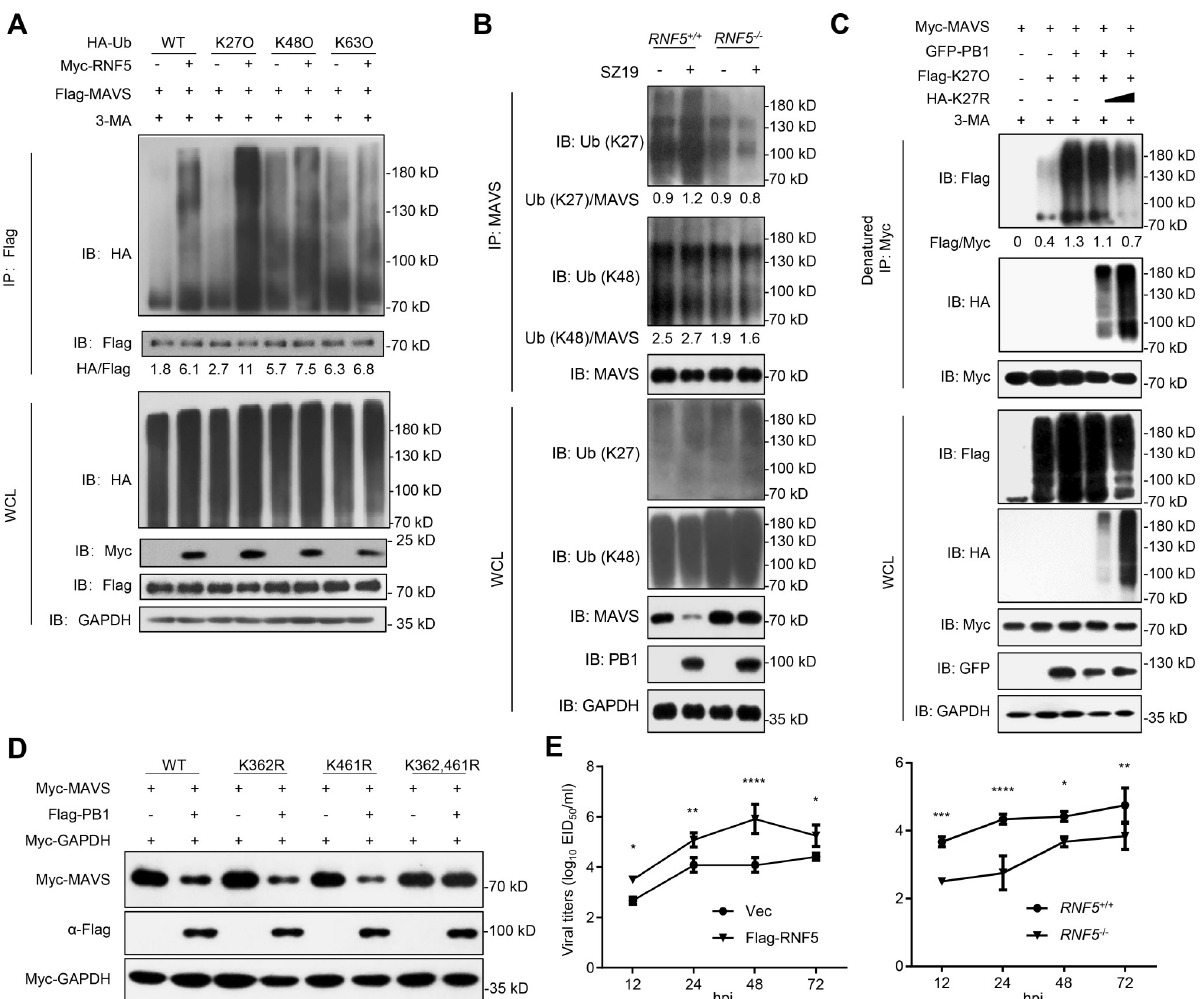
Fig 7. H7N9 PB1 facilitates RNF5 to ubiquitinate MAVS. (A) RNF5 catalyzes K27-linked ubiquitination of MAVS. HEK293 cells were transfected with Flag-MAVS, HA-ubiquitin, or its mutants (KO, K-only) together with a control and Myc-RNF5 plasmids for 20 h. The cells were then treated with 3-MA for 6 h before use in ubiquitination assays with the indicated antibodies. The intensities of the indicated protein bands were determined by using image J, were normalized to Flag-MAVS, and are shown as the fold-change of HA/Flag. (B) RNF5 deficiency inhibits SZ19-triggered K27-linked ubiquitination of MAVS. RNF5 -/- and control cells were infected with SZ19 virus (MOI = 0.1) for 24 h. The cells were then treated with 3-MA for 6 h before use in ubiquitination assays with the indicated antibodies. The intensities of the indicated protein bands were determined by using image J, were normalized to MAVS, and are shown as the fold-change of the indicated Ub/MAVS. (C) K27R ubiquitin inhibits PB1-mediated K27-linked ubiquitination of MAVS. HEK293 cells were transfected with Myc-MAVS, Flag-K27O, and HA-K27R (which K27 lysine residues was mutated to arginine) together with a control and GFP-PB1 plasmids for 20 h. The cells were then treated with 3-MA for 6 h before use in ubiquitination assays with the indicated antibodies. The intensities of the indicated protein bands were determined by using image J, were normalized to Myc-MAVS, and are shown as the fold-change of Flag/Myc. (D) MAVS bearing the K362 and 461R mutations is resistant to PB1-mediated degradation. HEK293 cells were transfected with Myc-MAVS and the indicated mutants in the presence or absence of Flag-PB1 for 24 h before immunoblot analysis. (E) The effects of overexpression or knockout of RNF5 on SZ19- Δ F2 virus replication. HEK293 cells were transfected with control vector or RNF5 plasmid for 24 h. The cells were then infected with SZ19- Δ F2 virus (MOI = 0.01) for the indicated times. The supernatants were harvested for virus titration (EID 50 /ml) (left). RNF5 -/- or control cells were infected with SZ19- Δ F2 virus (MOI = 0.01) for the indicated times. The supernatants were harvested for virus titration (EID 50 /ml) (right). The data shown represent three independent experiments; bars represent the mean ± SD of the three independent experiments (n = 3). [ P < 0.05( � ), P < 0.01( �� ), P < 0.001( ��� ), P < 0.0001( ����